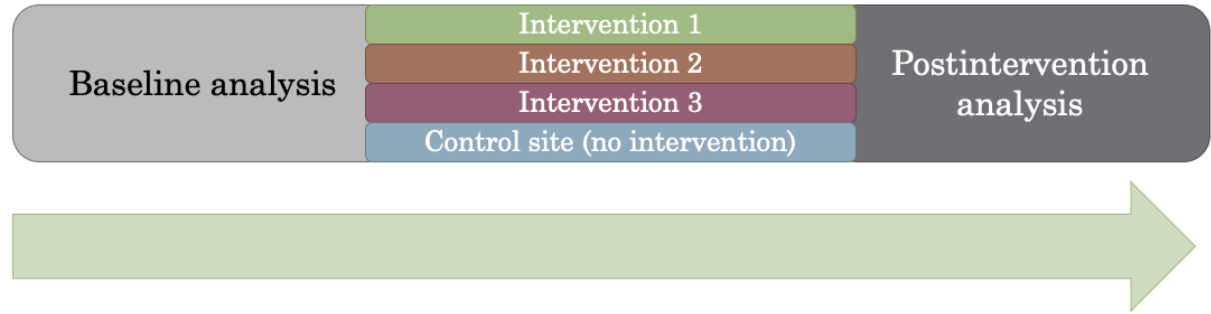
Figure 2. General structure of the